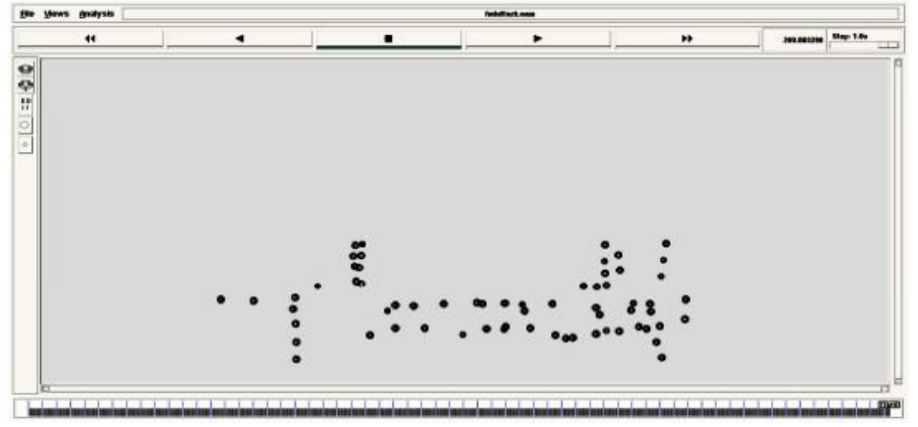
Figure 8. The end of the operation as shown in NAM.